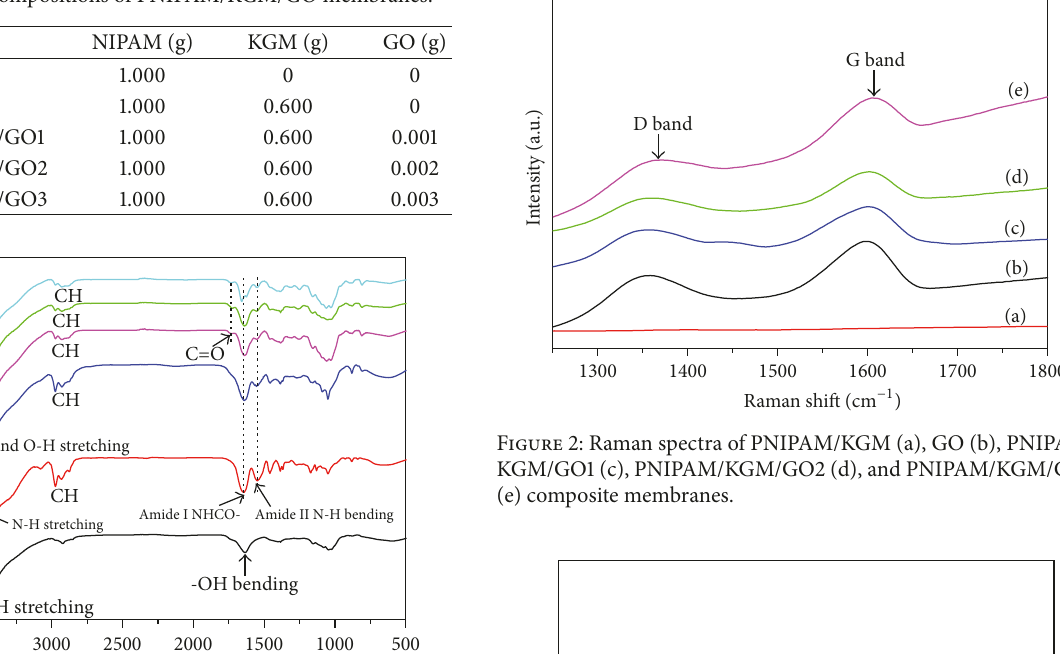
Table 1: The compositions of PNIPAM/KGM/GO membranes.